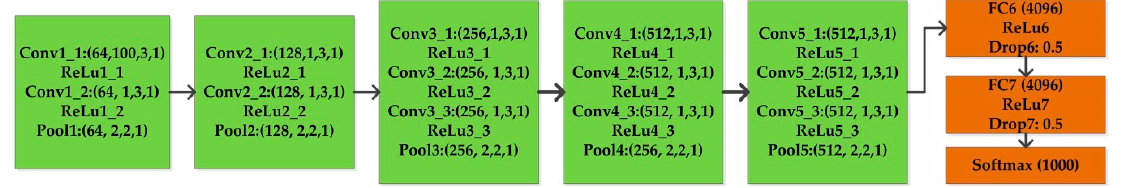
Figure 1. The architecture of VGG16. The green boxes indicate the convolutional blocks, and the brown boxes represent the fully connected blocks.